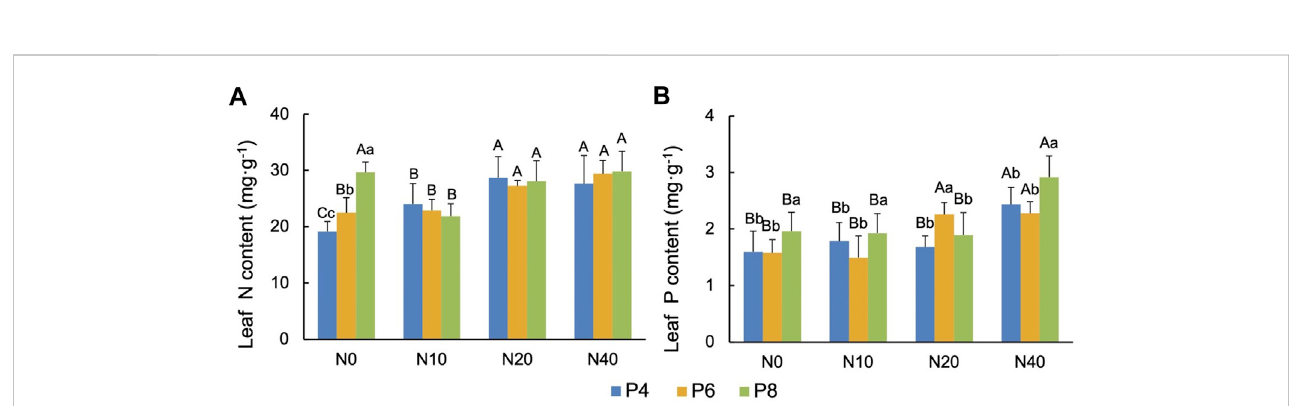
FIGURE 2 EffectsofNandPadditionon (A) totalNcontentand (B) totalPcontentinleavesof P.tanacetifolia .Differentcapitallettersindicatesigni fi cantdifferences ( p < .05) between groups of N addition treatments in the same P treatment group, and different small letters indicate signi fi cant differences ( p < .05) between different P addition treatments in the same N treatment group, similarly for the following fi